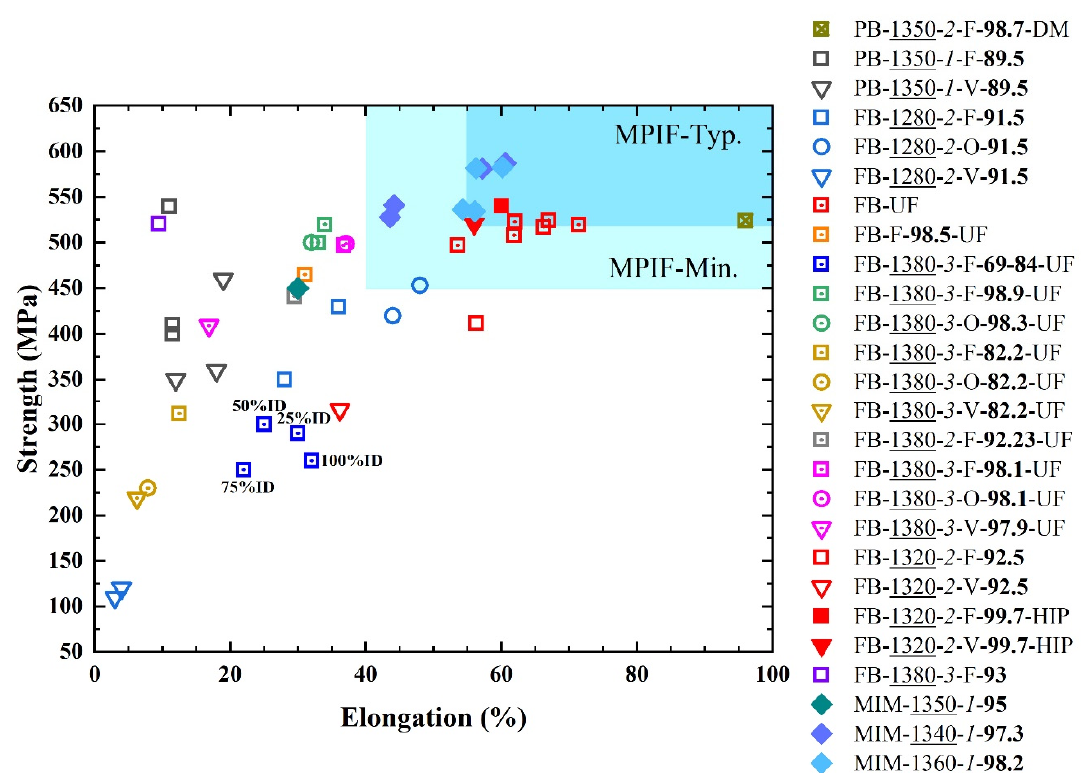
Figure 23. Stress vs. elongation map of 316L stainless steel fabricated by the metal MEX process with different conditions comparing with MPIF standard 35 for MIM materials. The underlined number represents sintering temperature (°C) and the italic number represents sintering time (h). F, O and V represent flat, on-edge and vertical printing orientations, respectively, and the bold number represents relative sintered density (%). ##% ID is the infill density. DM is utilising Desktop Metal system. Data from [9,45,53,56,57,66,68,75,81,93,98,108,160,161,169,171,172].